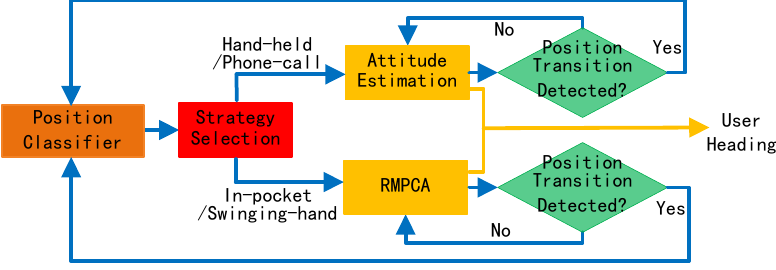
Figure 5. Flow chart of the user heading estimation approach.